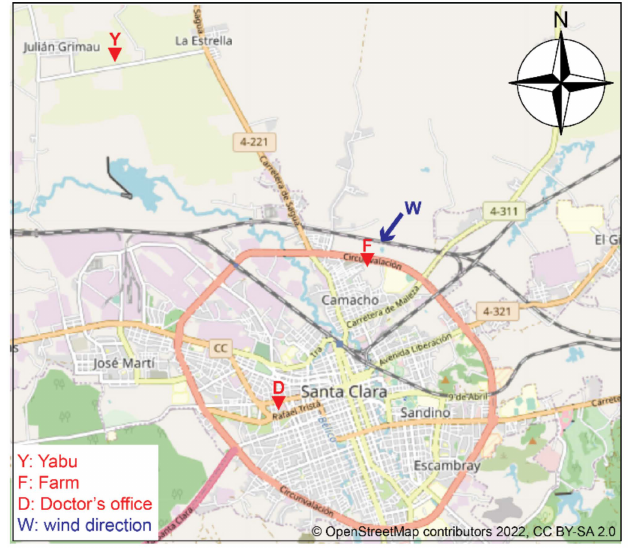
Figure 5. Map showing the three sampling sites in Santa Clara,